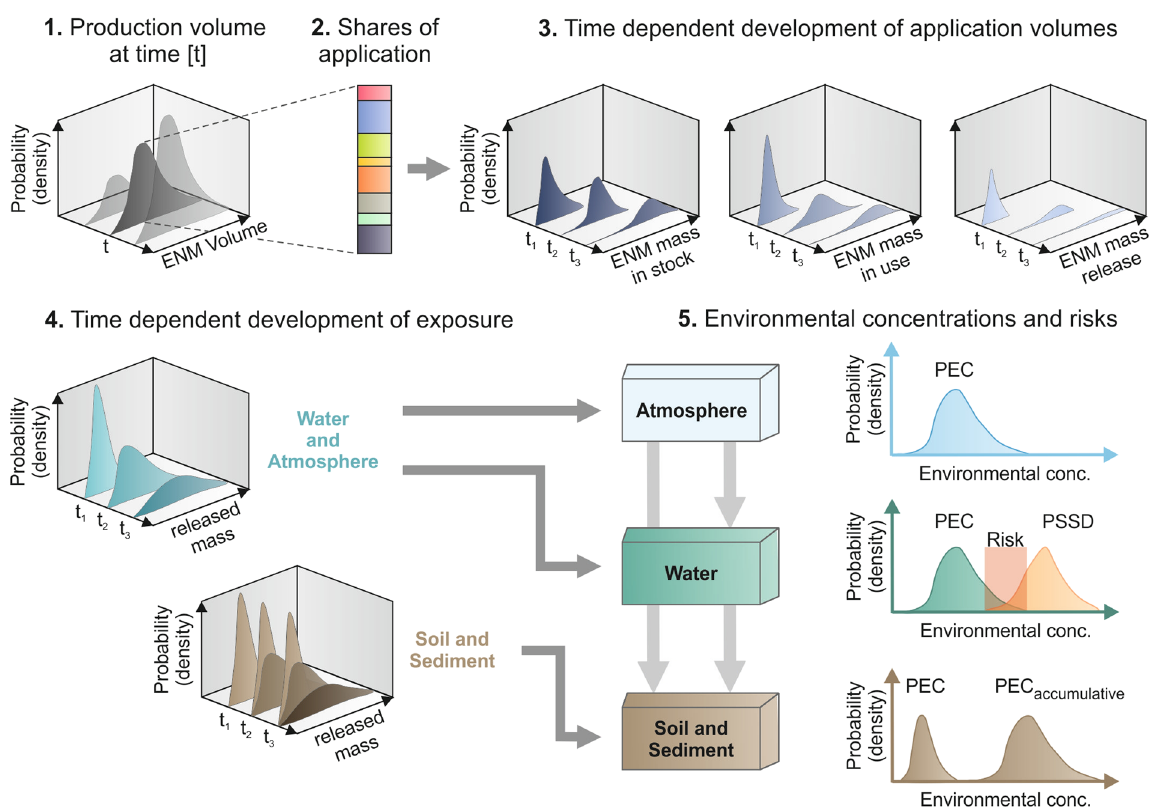
Figure 1. Data processing scheme for the calculation of a PEC and risk assessment. Each ENM was examined separately in the given order. After an initial estimation of the annual production volume of the respective ENM (1), according to the shares for different applications in processes and products, the mass fractions for these uses were calculated (2). Based on general trends for production volume, and taking into account factors for ENM release during its production, manufacture of ENM-containing products, use of ENMs and respective products, and end-of-life (EOL), the temporal distribution of ENM volumes for (i) stock, (ii) use, and (iii) release were determined stochastically (3). Information on release volumes enabled the computation of temporal probability distributions of ENM volumes in the atmosphere, water, and soil incl. sediment (4). To consider a large range of potential ENM concentrations for soil and sediment, we took into account two options for the persistence of ENM: on the one hand, an annual degradation of the released amount and, on the other hand, full ENM persistence and therefore an accumulation of annual releases that lead to considerably higher environmental concentrations of the respective ENM (PEC accumulative ). Besides the relevant volume within the environmental compartments, flux between compartments has to be considered for the calculation of PEC (gray arrows). Comparison of PEC with probabilistic species sensitivity distribution (PSSD) curves for the three investigated ENMs enabled a risk evaluation for